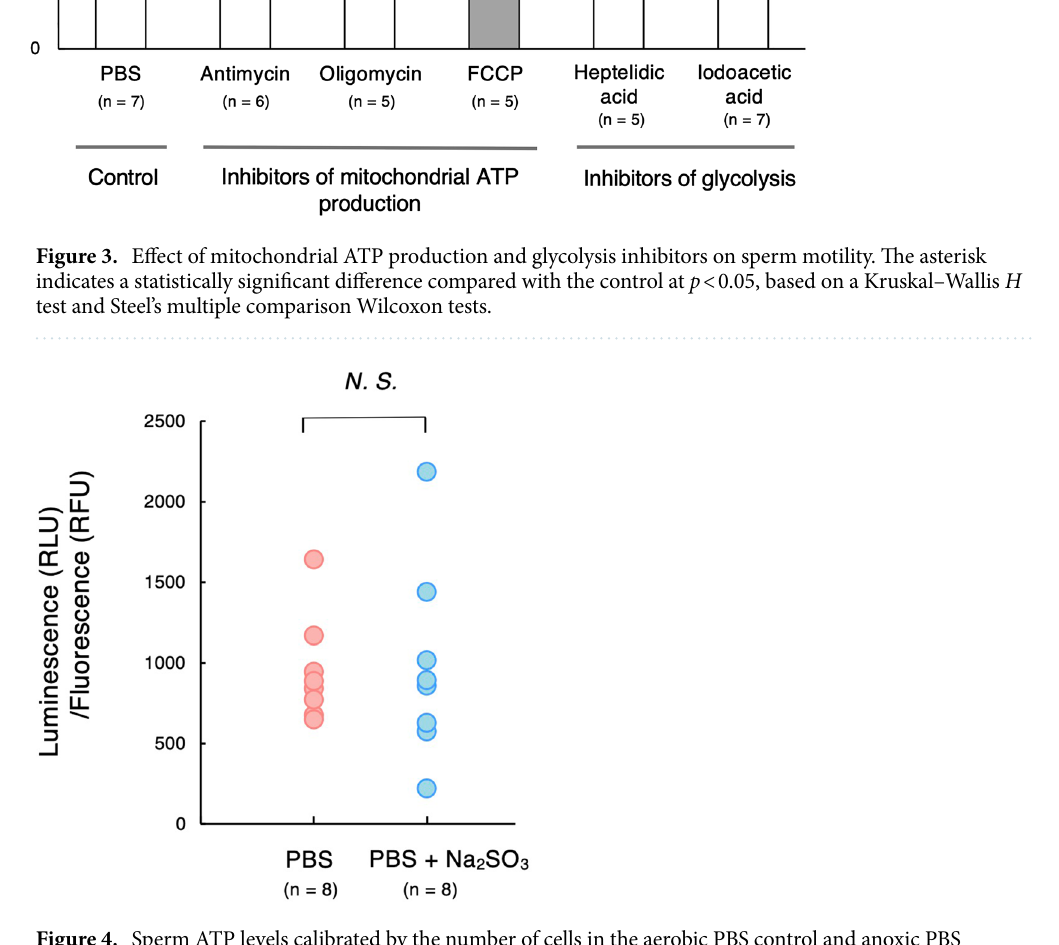
Figure 4. Sperm ATP levels calibrated by the number of cells in the aerobic PBS control and anoxic PBS (created by adding sodium sulfite). RLU, relative luminescence unit; RFU, relative fluorescence